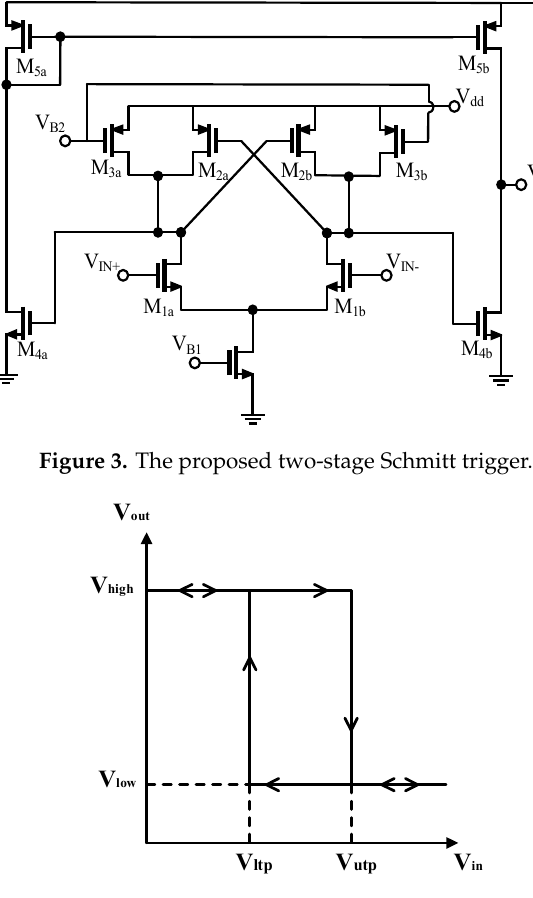
Figure 4. Qualitative hysteresis characteristic of the two-stage Schmitt trigger.